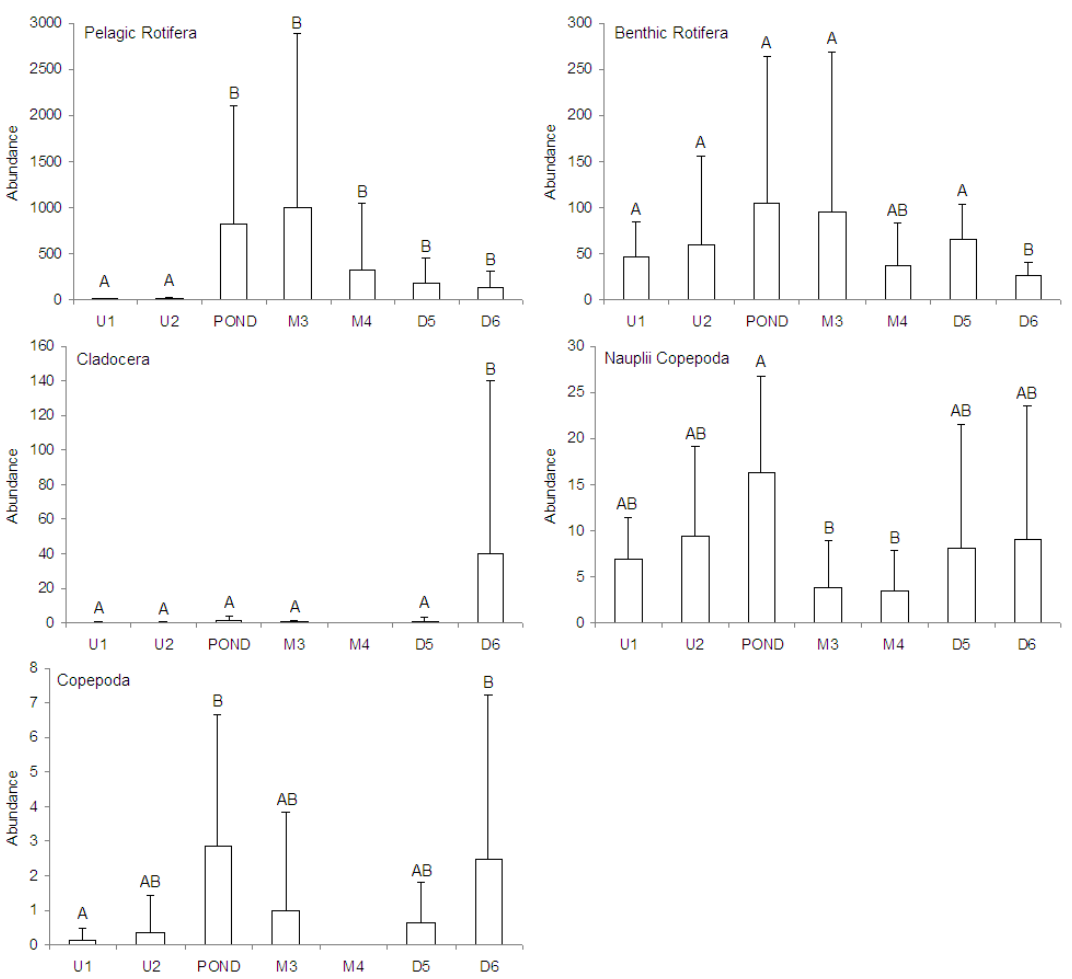
Figure 4. Spatial changes of the mean + SD zooplankton group abundance at two sites in upper section (U1, U2), in POND, at two sites in the middle section (M3, M4), and at two sites in the downstream section (D5, D6) of the Bukówka stream. The different letter on the column show significant differences between sites (P < 0.05).